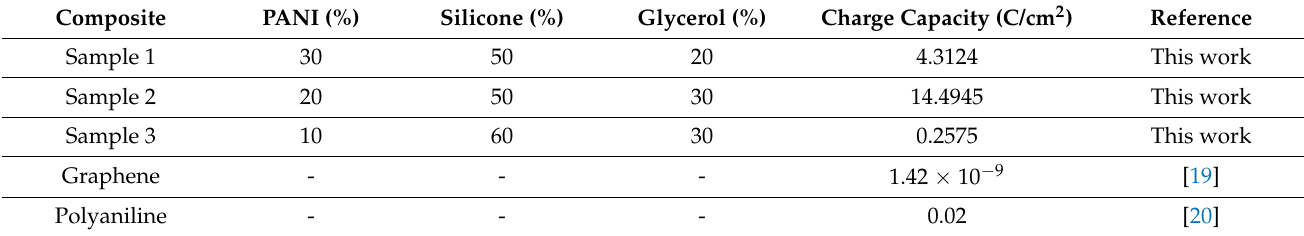
Figure 3. Cyclic voltammetry ( a ) and the relationship between current and time ( b ) for sample 1 (the best performing sample) in Table 2. The scanning rate is 10 mV/s. Table 3. A comparison table for charge capacity for the first batch of the prepared samples.